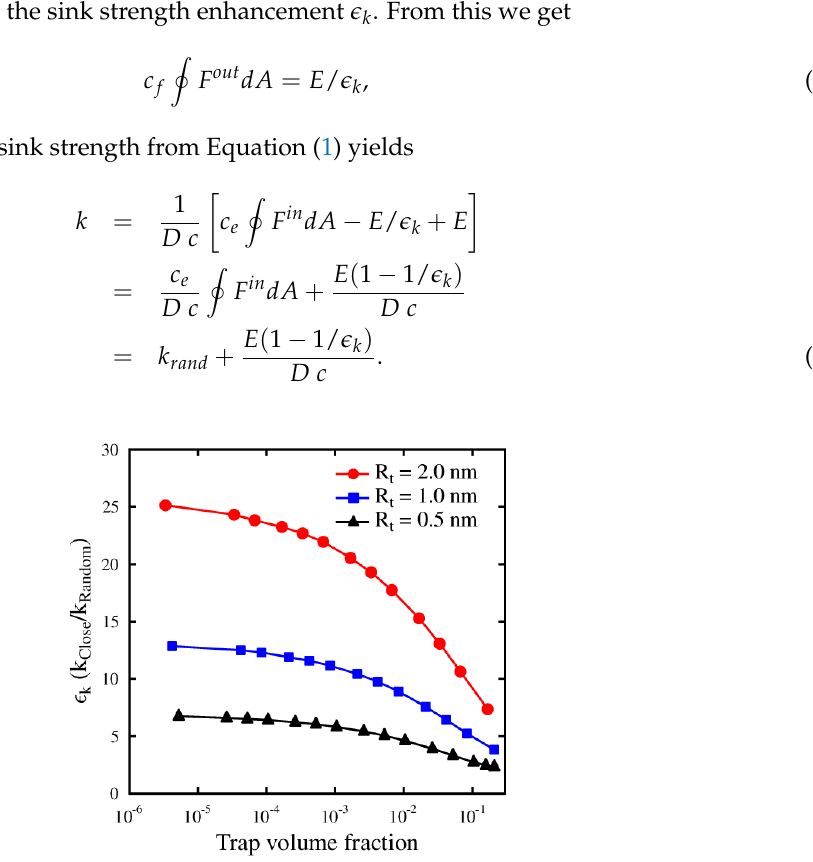
Figure 2. The enhancement factor (cid:101) k for sink strengths as a function of trap volume fraction for three different trapping radii. At high trap concentrations, the probability of a defect to be trapped to other than the nearest trap increases, which is seen as a decrease in the (cid:101) k